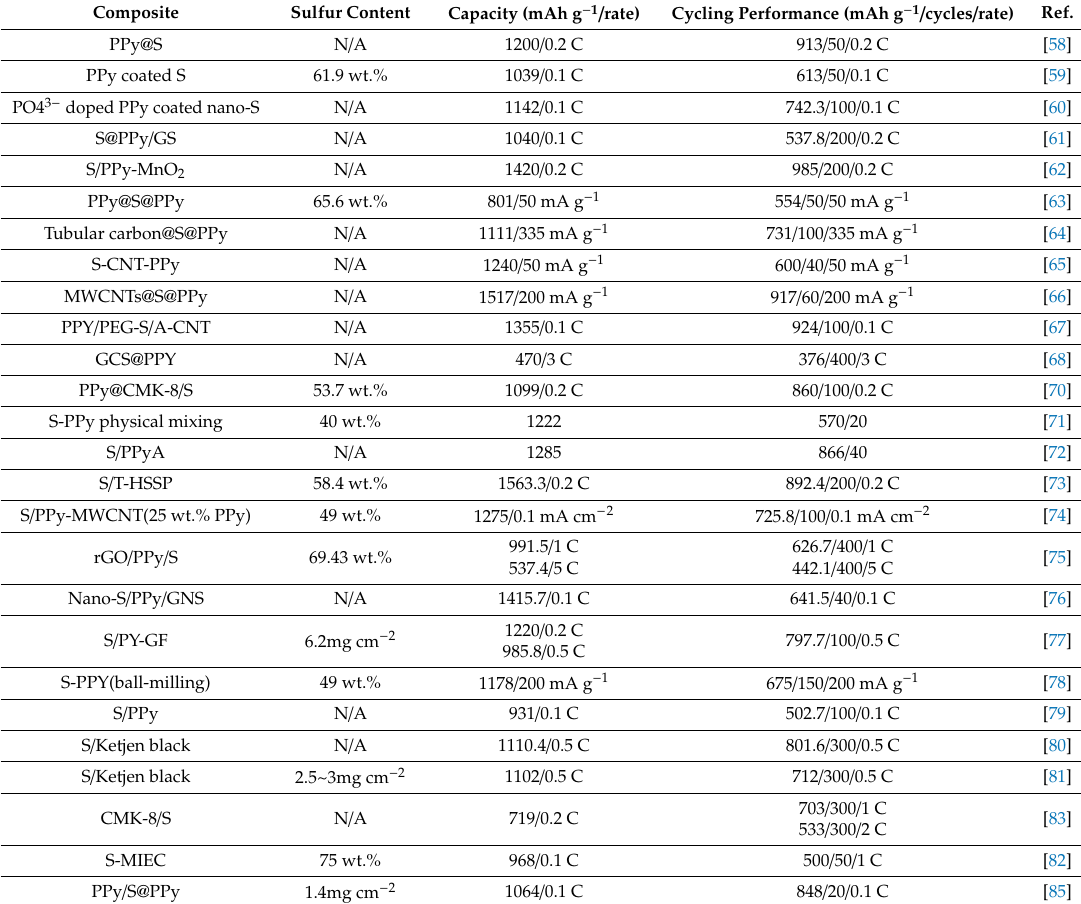
Table 2. The performance of PPy-based composite in Li-S